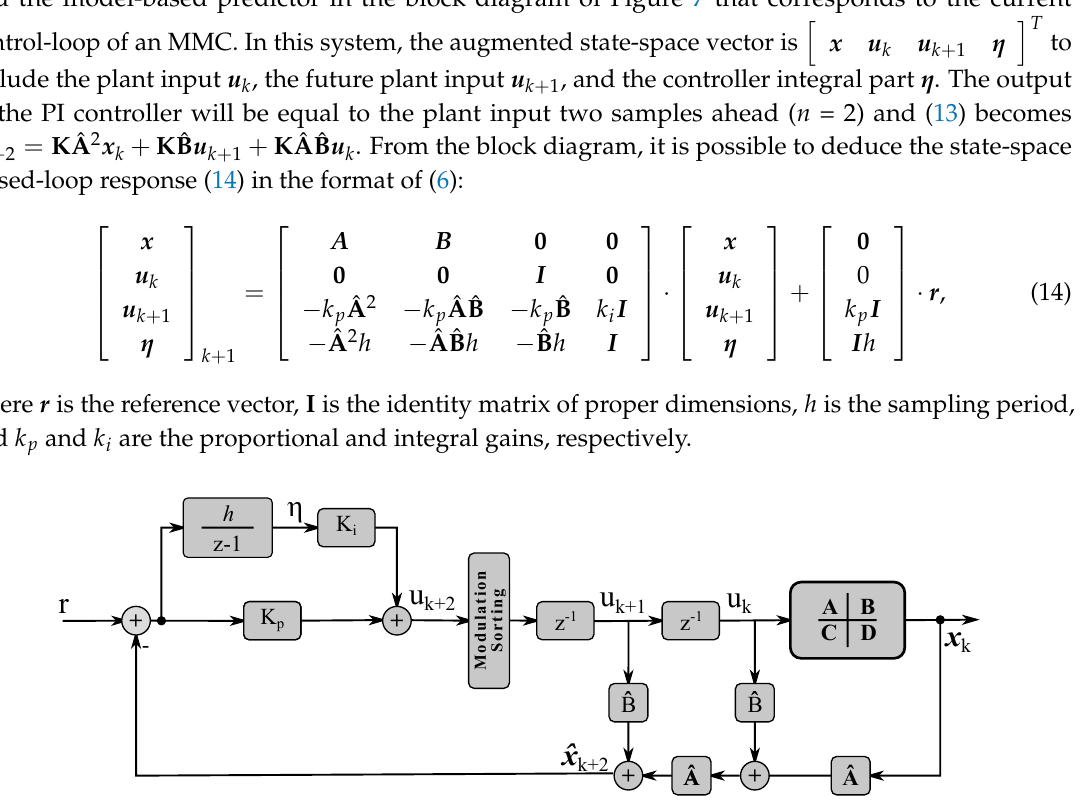
Figure 7. Block diagram of a closed-loop system with two loop delays, a PI controller, and the model-based